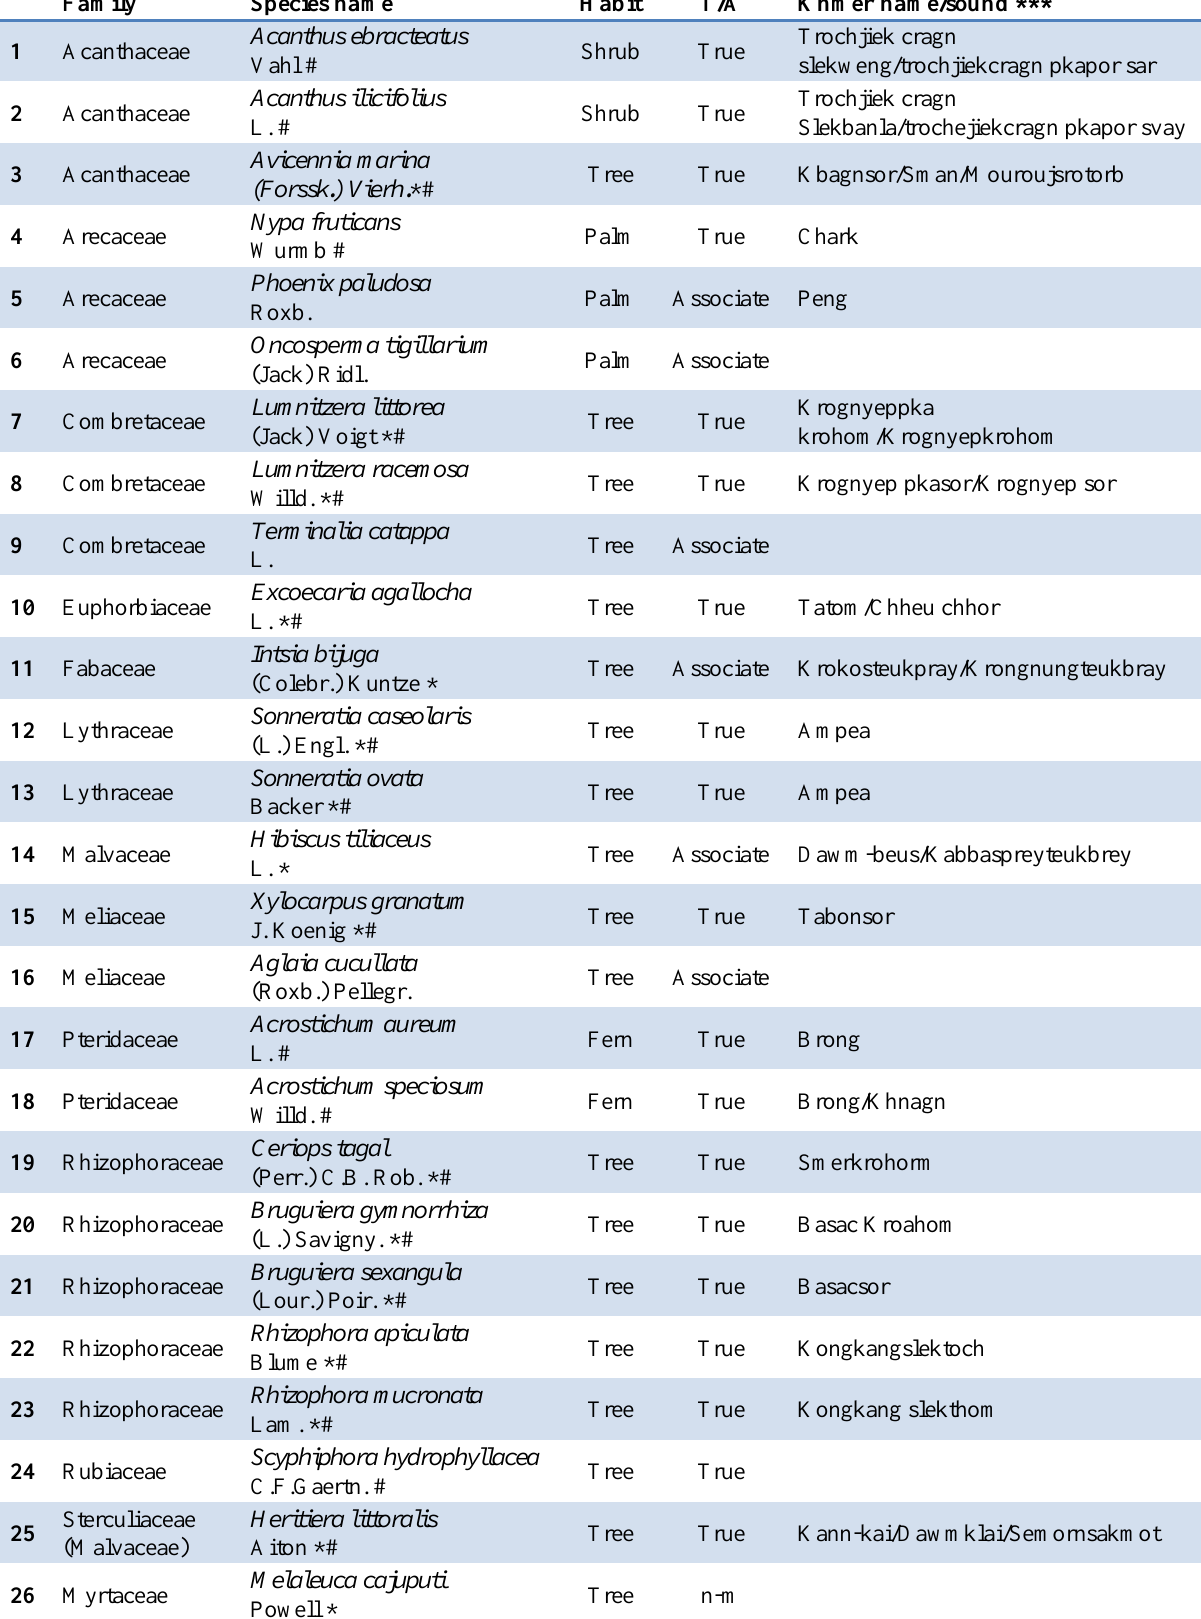
Table 1. Mangrove species found in Botum Sakor, Cambodia. Key: T/A = True or Associate mangrove species; n-m = non-mangrove; *indicates species shared with Chantaburi province, Thailand (Suk-ueng et al . 2013); # indicates species shared with Singapore (Yang et al . 2011); *** Khmer name/sound follows UNEP (2008).